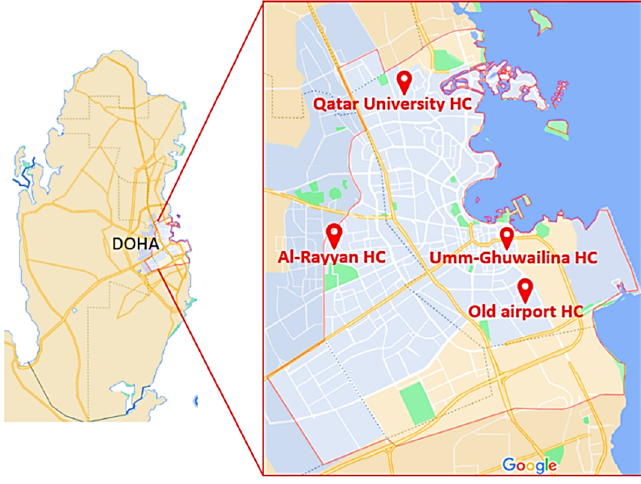
Figure 1. Map of Qatar showing the locations of the four PHCCs in Doha city where samples were collected: Qatar University, Al-Rayyan, Umm-Ghuwailina, and Old Airport health centers.